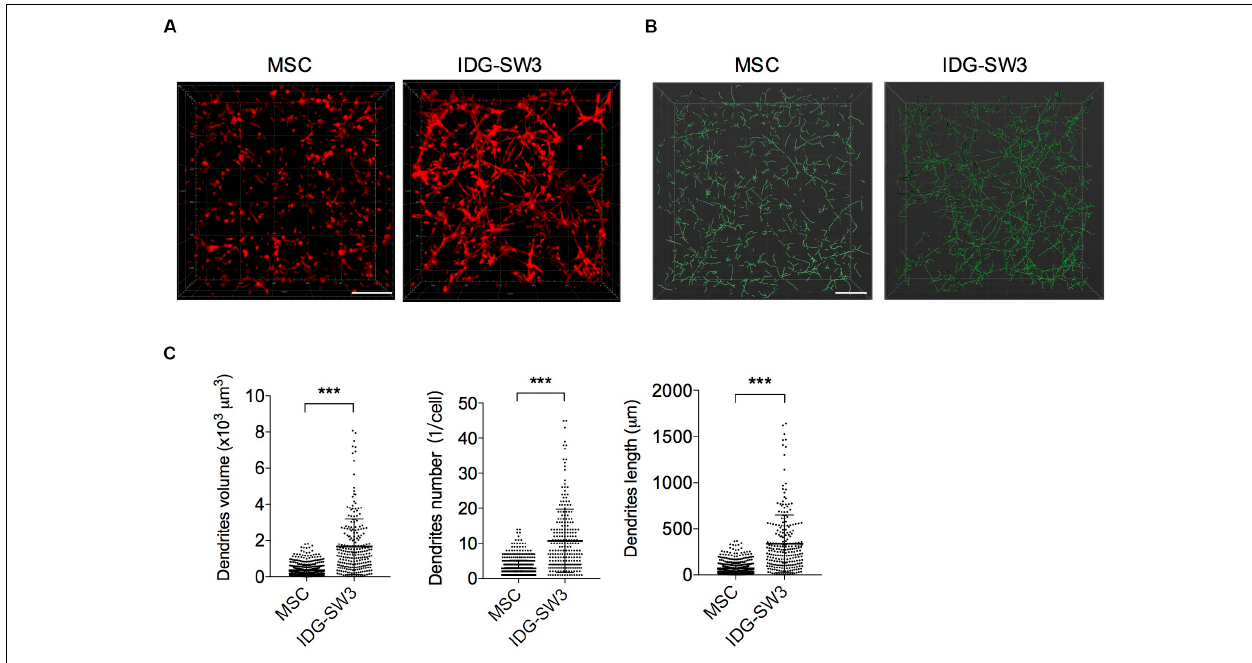
FIGURE 1 | Extensive dendrite network of IDG-SW3 cells cultured in collagen gel. (A) Representative images of cytoskeleton, stained by phalloidin from IDG-SW3 cells and BMSCs cultured in 3D type I collagen gel with osteogenic medium after 7 days. (B) Dendrite network modeling of IDG-SW3 cells and BMSCs, analyzed by Filaments module of IMARIS software with the cytoskeleton images (A) as original data. (C) Parameters of the dendrite network analyzed by IMARIS software and shown with scatter plots. Bars, 200 µ m. Data were represented as means ± s.e.m. *** P <